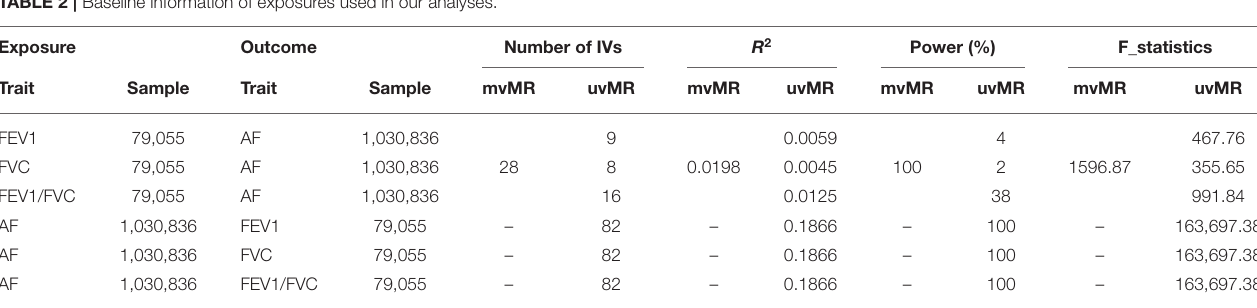
TABLE 2 | Baseline information of exposures used in our